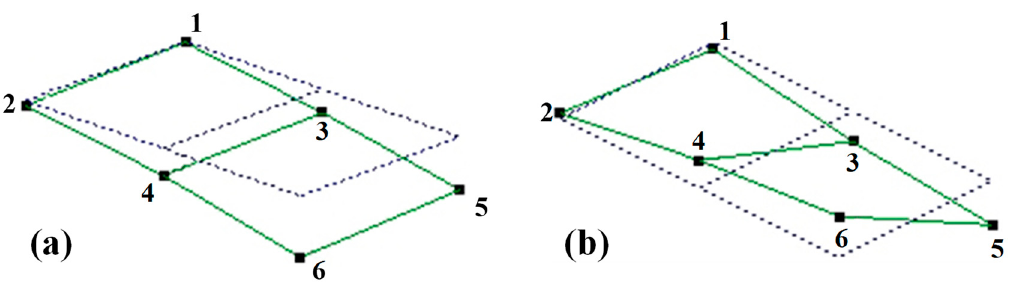
Figure 5. The first two vibrational modes of two kinds of sandwich plates obtained by the M+P dynamic analysis system (measuring points are marked with number from 1 to 6): ( a ) first-order vibrational mode (first-order bending) and ( b ) second-order vibrational mode (first-order torsion).